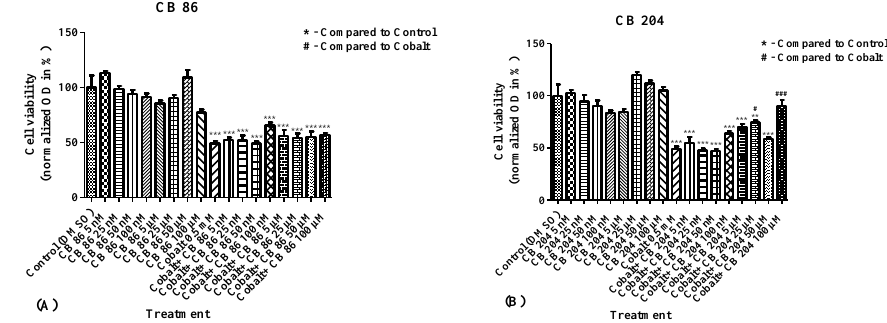
Figure 2. Dose response analysis of CB86 and CB204 ligands in inhibition of cellular viability decrease induced by CoCl 2 . XTT assay was performed to measure the levels of cellular viability following exposure to CoCl 2 after pretreatment with ( A ) CB86 and ( B ) CB204 at increasing concentrations. Results are expressed as mean ± SEM ( n = 5 replicates in each group). # p < 0.05, ## and ** p < 0.01, ### and *** p < 0.001.